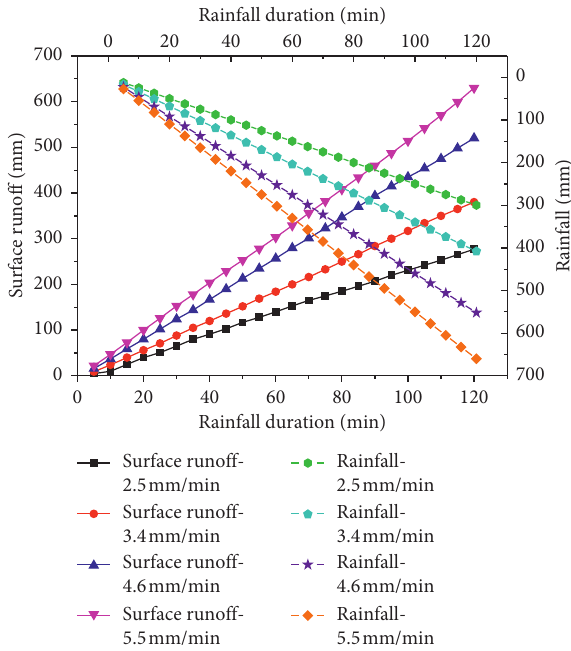
Figure 11: Dense asphalt